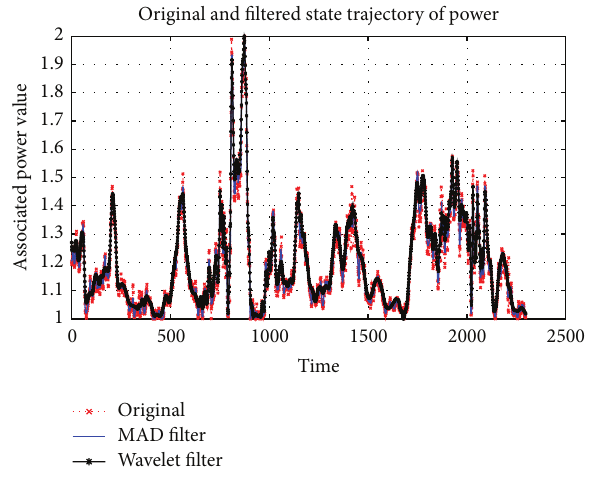
Figure 4: State trajectories refer to the 11th variable.